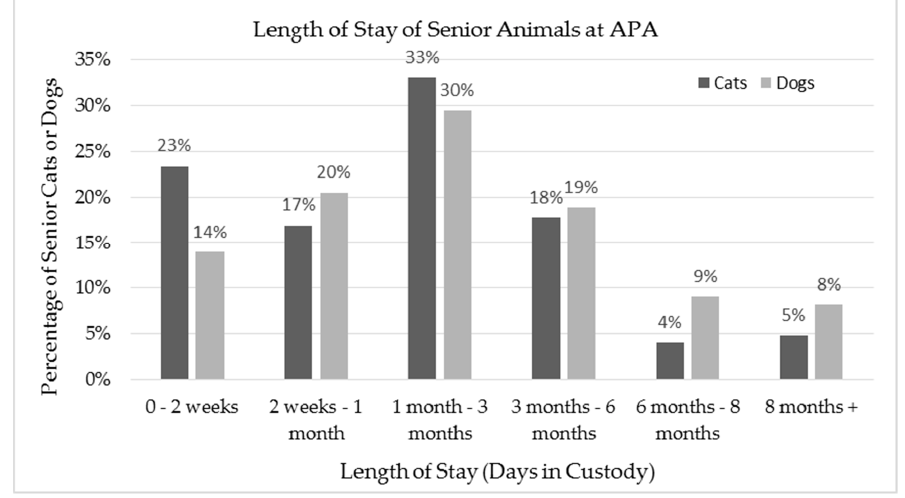
Figure 1. The total length of stay of the 124 cats and 122 dogs included in the sample, presented in percentage of all senior cats or senior dogs included in the sample.